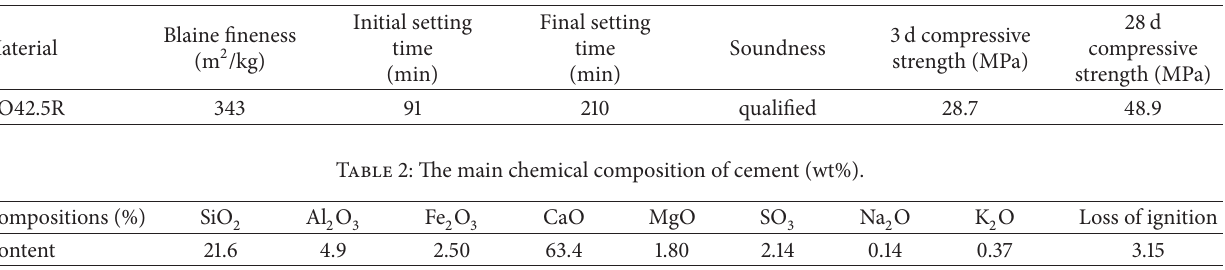
Table 1: The physical properties of cement.